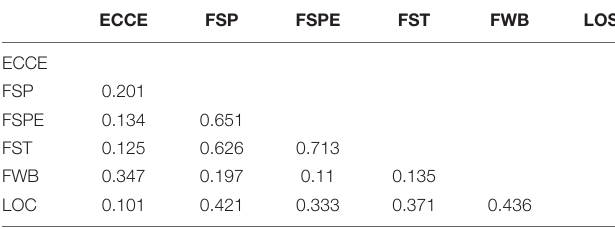
TABLE 2 | Factor loadings, average variance extracted, and composite reliability. TABLE 3 | Discriminant validity [Heterotrait-monotrait ratio